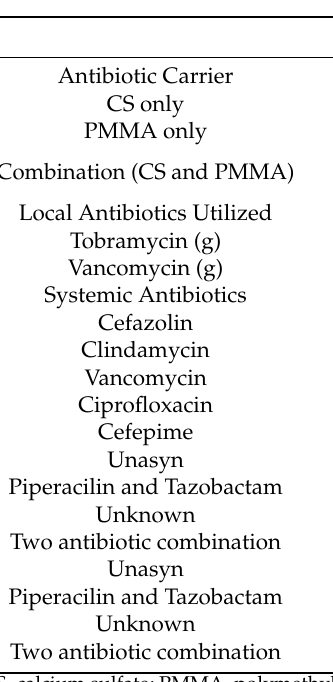
Table 2. Systemic and local antibiotic